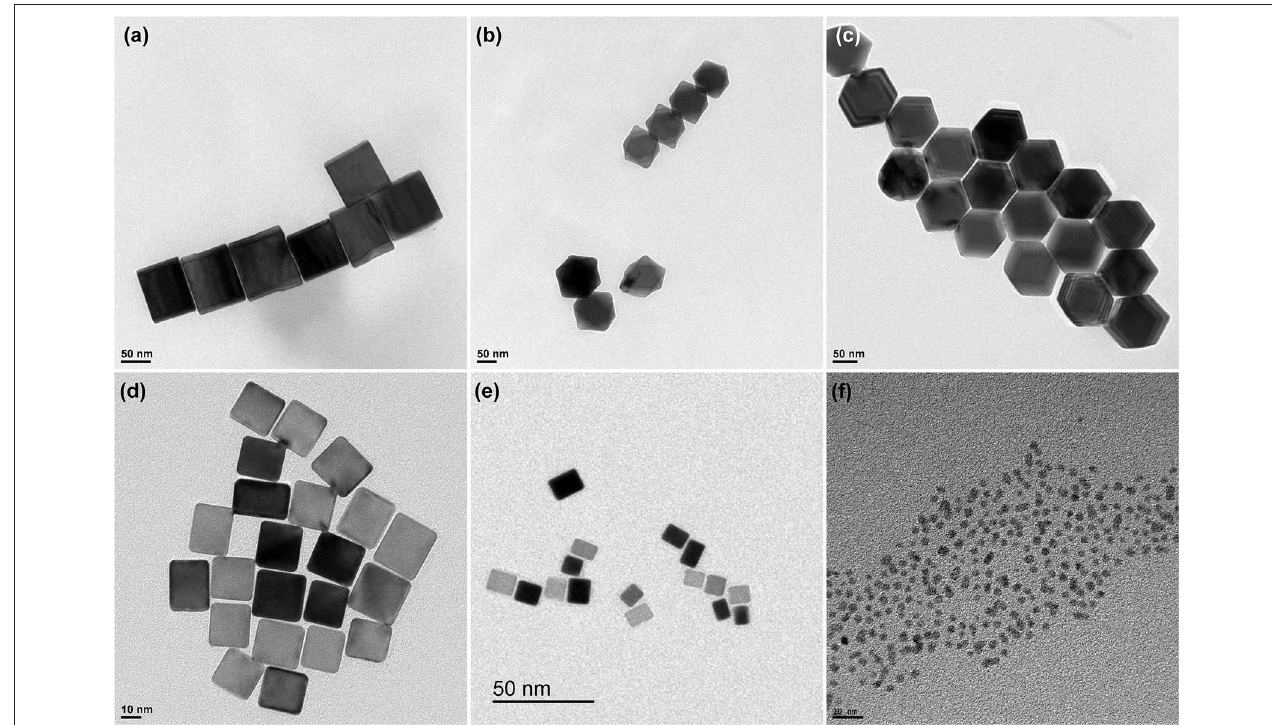
FIGURE 1 | Representative TEM images of the (a) Pd Cub, (b) Pd Oct , (c) Pd RD , (d) Pd 20 Cub , (e) Pd 10 Cub , and (f) Pd 3 Sp nanoparticles.